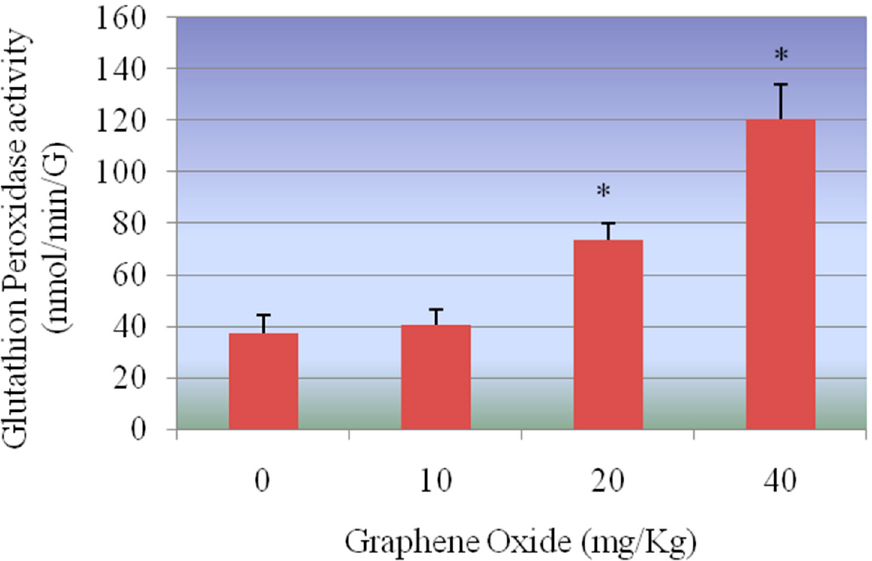
Figure 7. Effect of GOs on GPx activities in kidneys of rats after 5 days. Each bar represents mean ± SD of five rats. Values with asterisks were significantly different from control. Statistical significance ( p < 0.05) is depicted as ( * ).